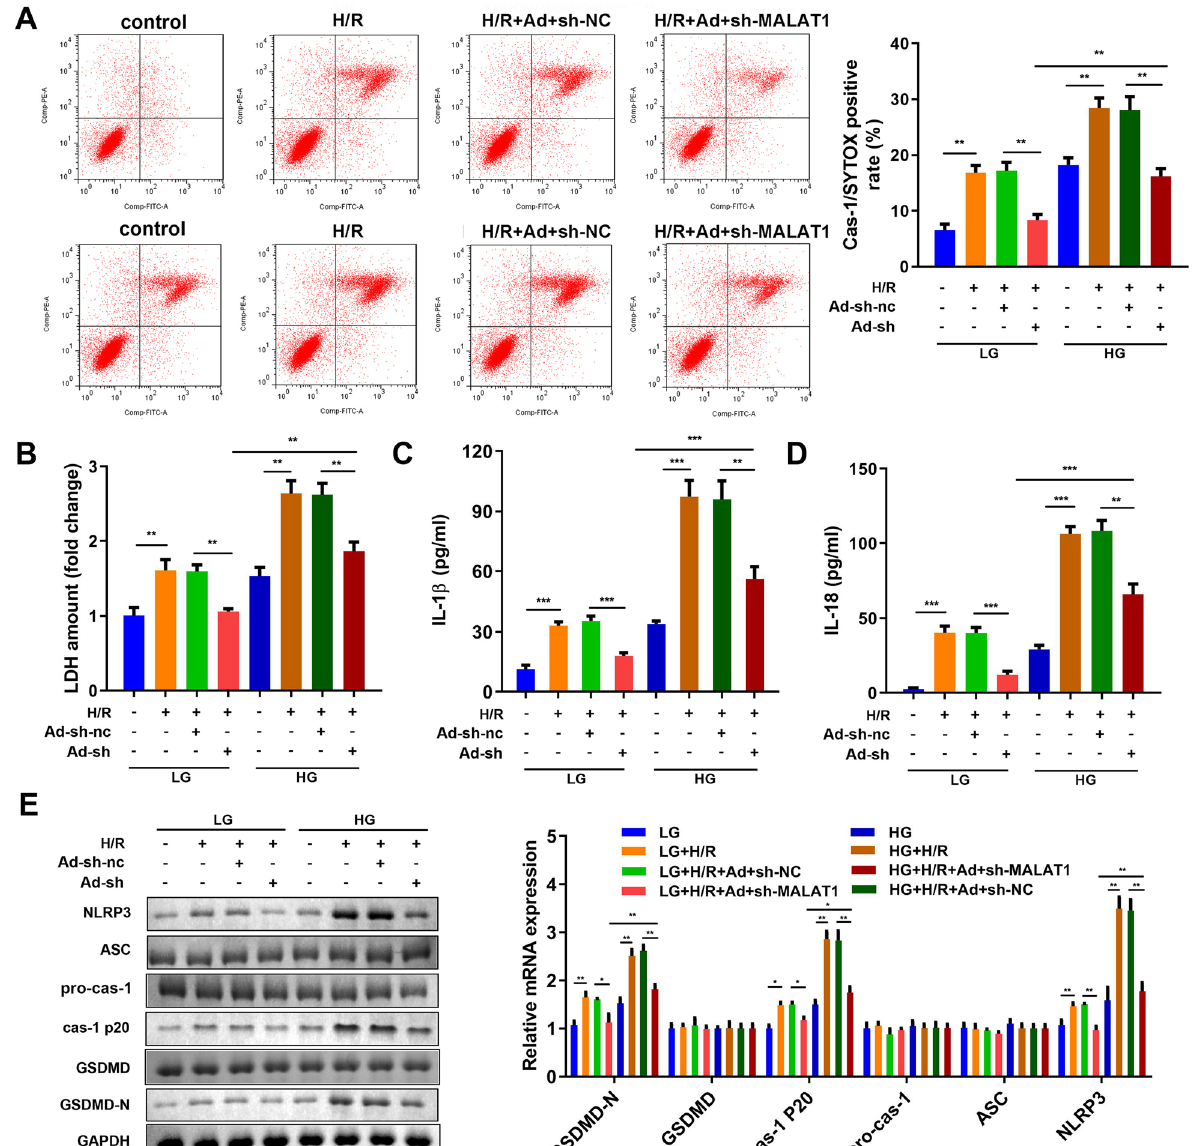
Fig. 4 Downregulation of MALAT1 inhibited pyroptosis and cytotoxicity induced by high glucose and H/R of the BV2 cells. A Cspase-1/SYTOX positive cells were counted by flow cytometry. B LDH concentrations of the BV2 cells were detected with ELISA kit 72 h after indicated treatments. LDH amount was expressed as the fold to the LDH level of the NG group. IL-1β ( C ) and IL-18 ( D ) and concentrations in the BV2 cells were measured by ELISA kit 72 h after indicated treatments. E The protein expression of GSDMD-N, GSDMD, caspase-1 p20, pro-caspase-1, ASC and NLRP3 were separated by western blotting assay. (n 6), ** P < 0.01, H/R, hypoxia/reoxygenation; LDH, lactate =